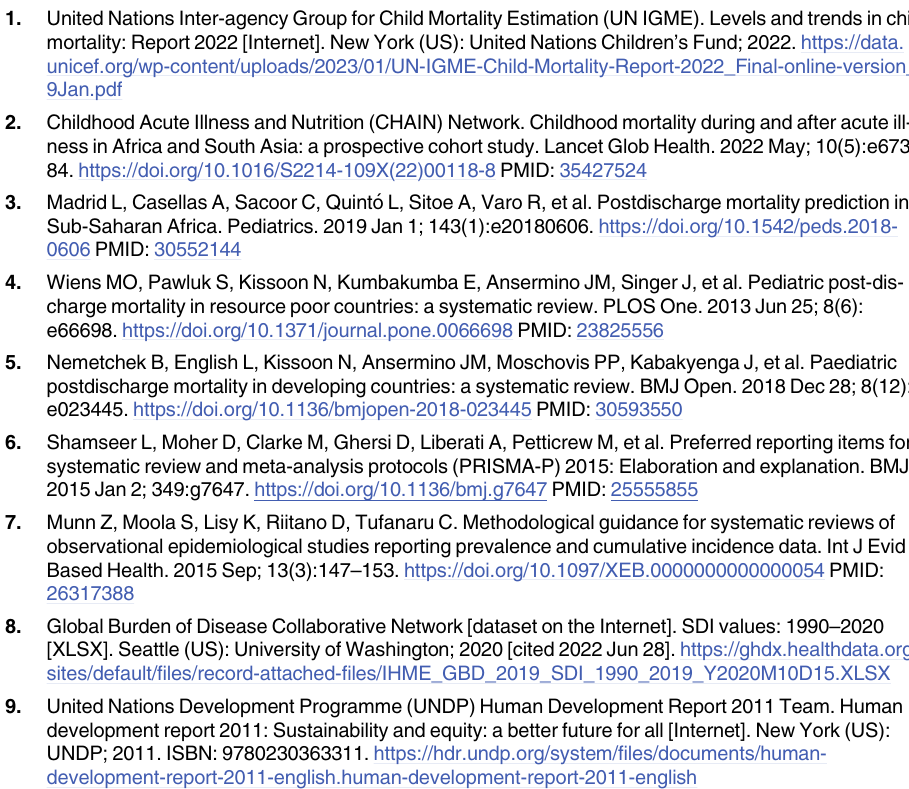
S7 Table. Extraction template for post-discharge mortality timeline. S8 Table. Extraction template for post-discharge mortality risk factors. S9 Table. Quality appraisal